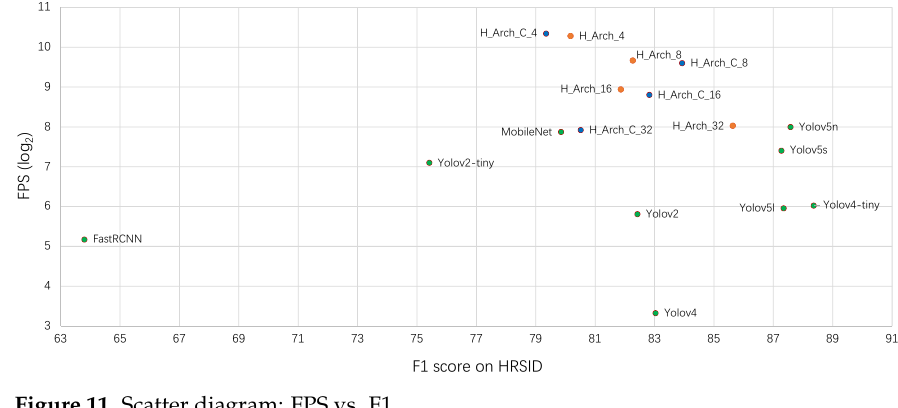
Figure 11. Scatter diagram: FPS vs. F1.